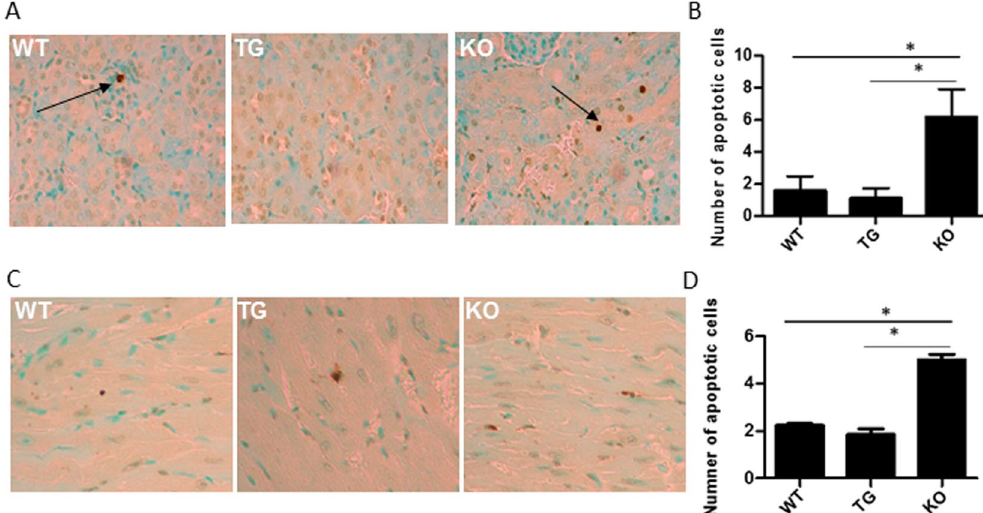
Figure 3. GDF15 KO mice have increased levels of apoptotic cells in kidney ( A,B ) and heart tissues ( C,D ). Formalin fixed, paraffin embedded sections of GDF15 WT, TG and KO mice treated with LPS were stained for the TUNEL assay. The number of stained cells were counted for each slide across ten sections at 200 X magnification and averaged. ( A,C ) are representative images. ( B,D ) are summarized data. n = 4; * P ≤ 0.05, ** P ≤ 0.01, *** P ≤ 0.001.